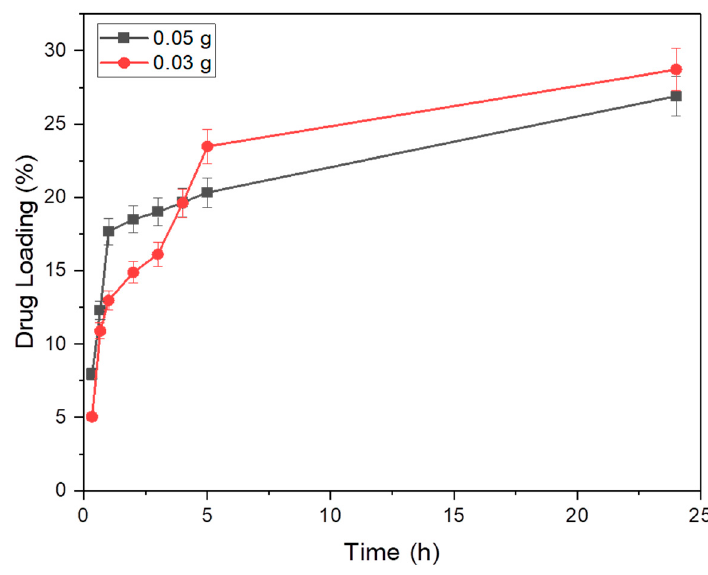
Figure 5. TEM image of PCD-zeolite-IB.